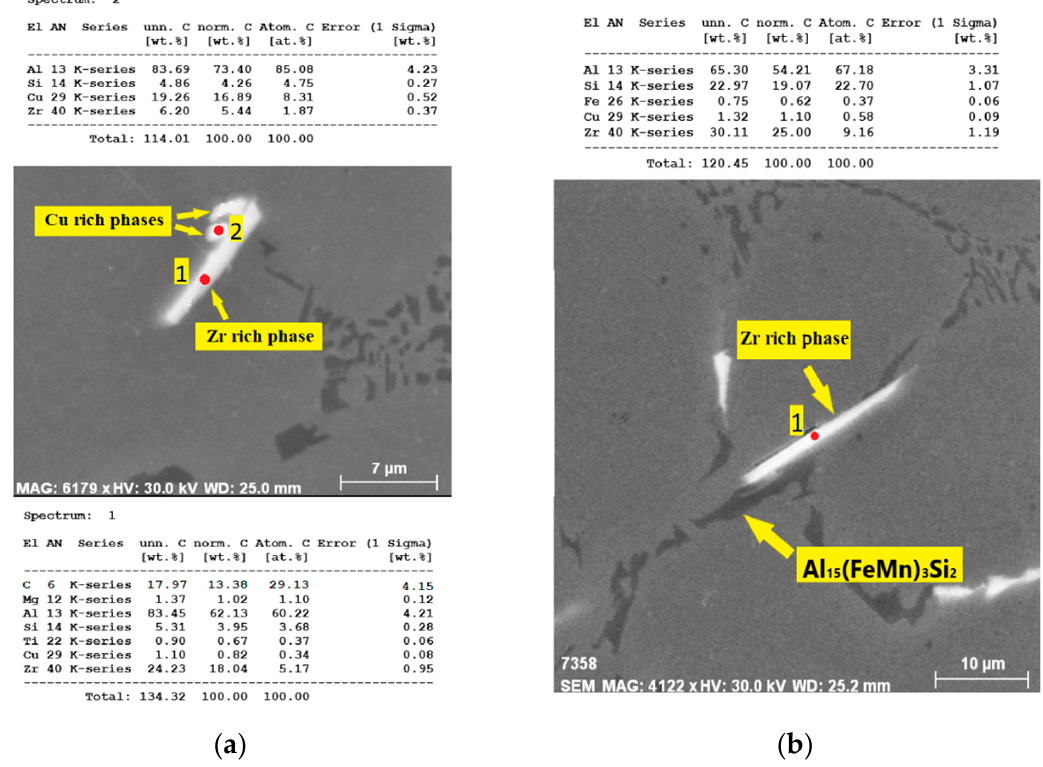
Figure 15. Interaction of: ( a ) Zr and Cu phases (0.15 wt. % Zr addition, as-cast, H 2 SO 4 etch.); ( b ) Zr and Fe phases (0.20 wt. % Zr addition, as-cast, H 2 SO 4 etch.).